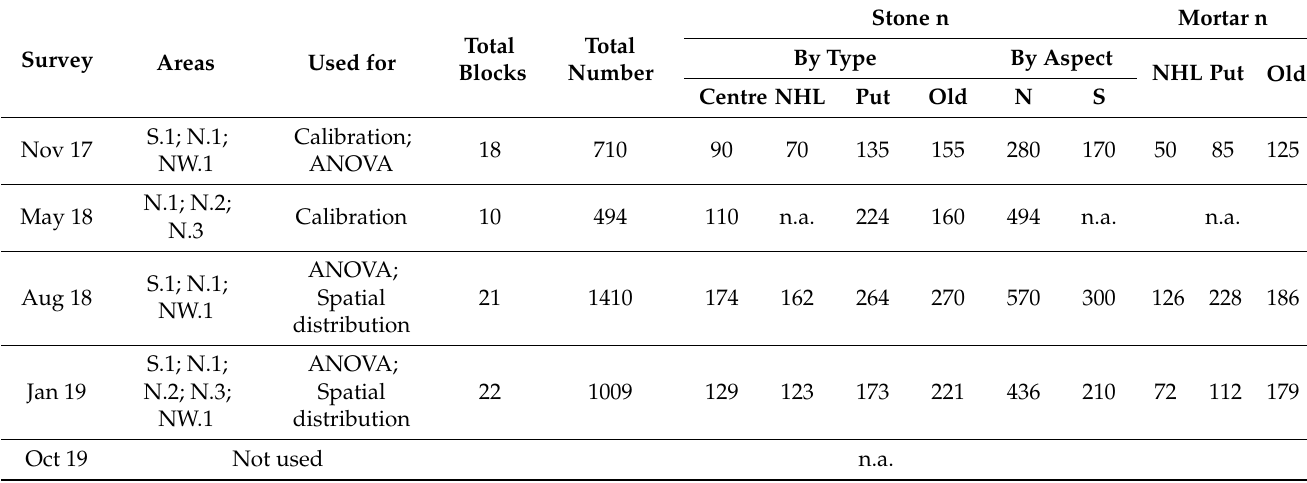
Table 3. Summary of surface hardness surveys, showing areas surveyed, types of analysis performed on data, and number of measurements made. Also includes distribution of measurements according to spatial and material